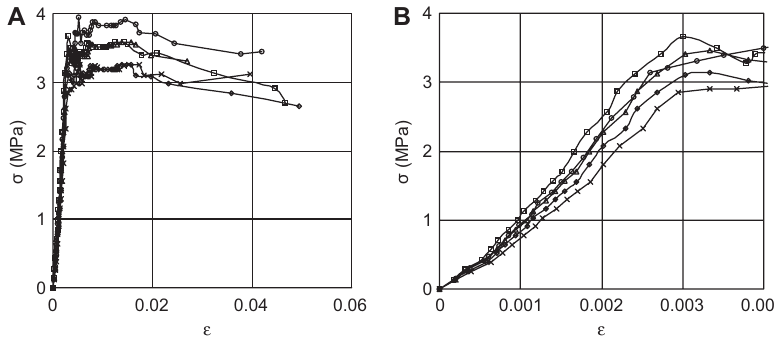
Figure 9 The complete axial stress vs. axial strain curves of authentic Kenchreae stone specimens subjected to compression (A) and a detailed view of the initial linear portion of the curves (B).